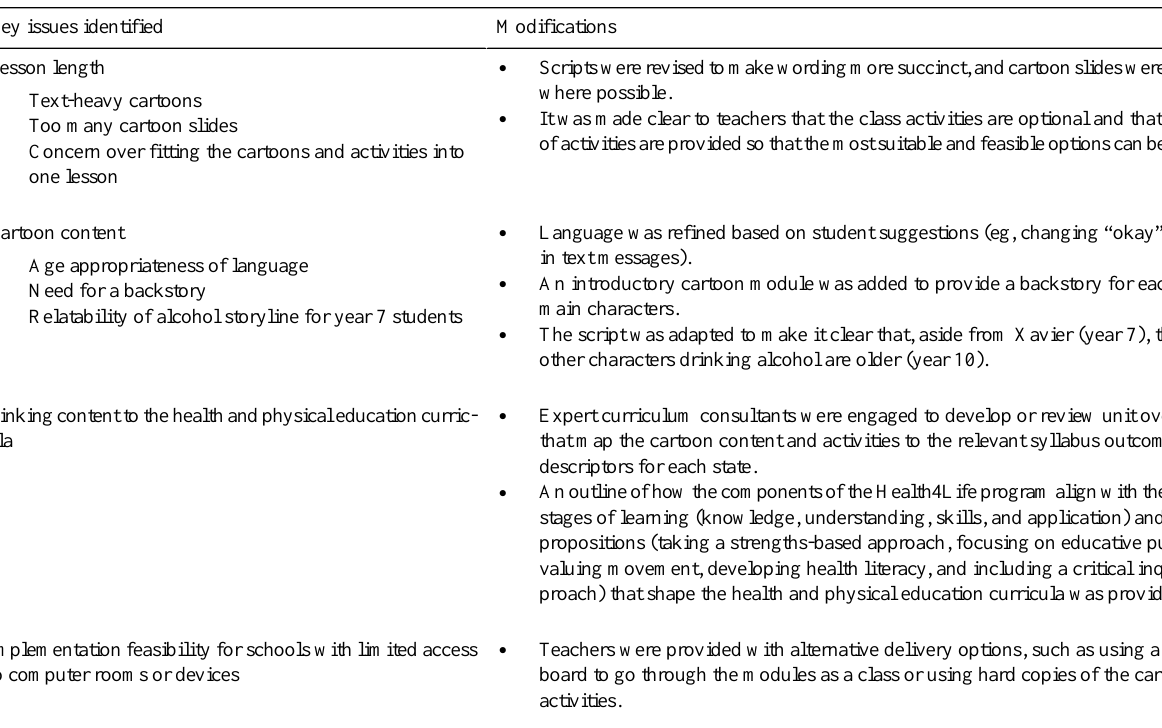
Table 7. Examples modifications made to the Health4Life